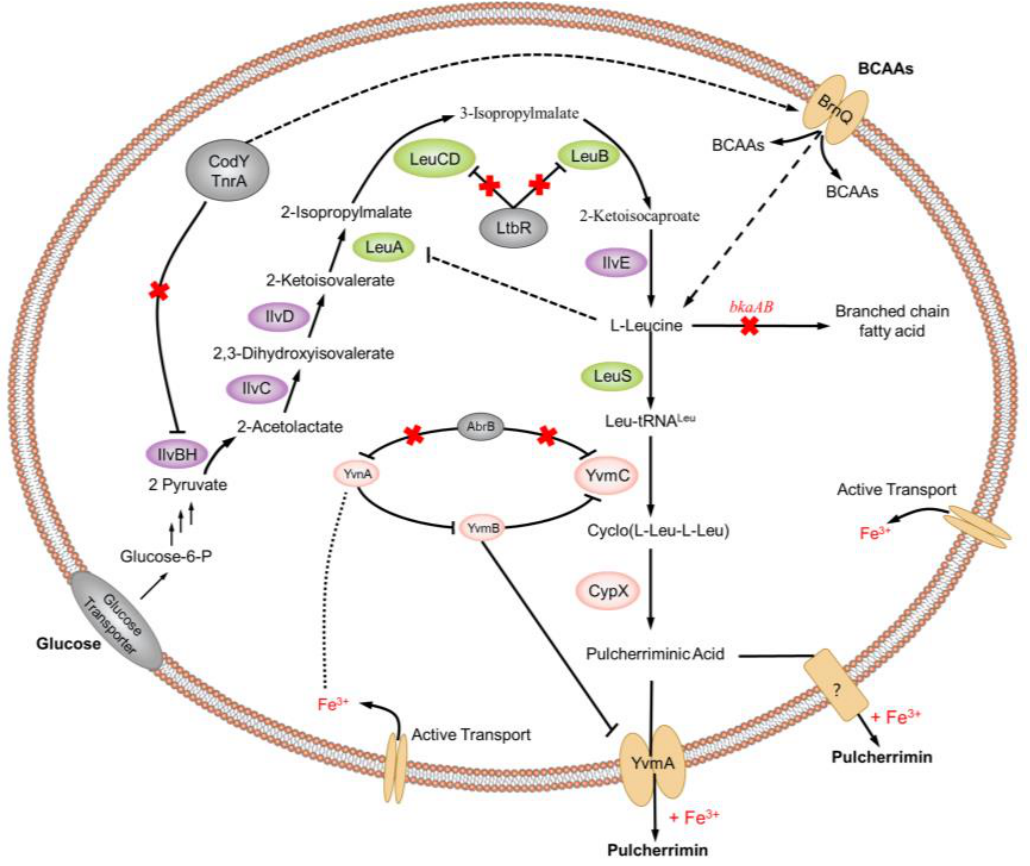
Figure 9. The synthesis regulation responsible for the synthesis of pulcherriminic acid in Bacillus . The black line with an arrow indicates the synthesis pathway of pulcherriminic acid, the black line with bars indicates inhibition, the black dashed line with bars indicates negative feedback, the red cross indicates deletion inhibition, and the red font indicates missing genes (except Fe 3 + ). The dotted line with arrow indicates the promotion e ff ect, and the dotted line indicates the e ff ect of iron ions on protein. BCAAs, branched chain amino acids.